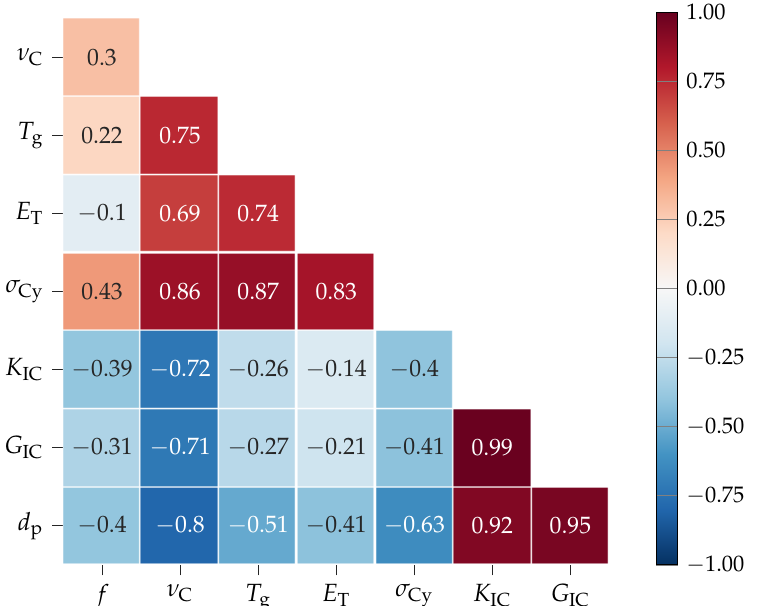
Figure 5. Pearson product moment correlation coefficients between functionality f , cross-link density ν C , glass transition temperature T g , Young’s modulus E T , compression yield strength σ Cy , critical stress intensity factor in mode I K IC , fracture energy G IC , and diameter of the plastic zone d p of the